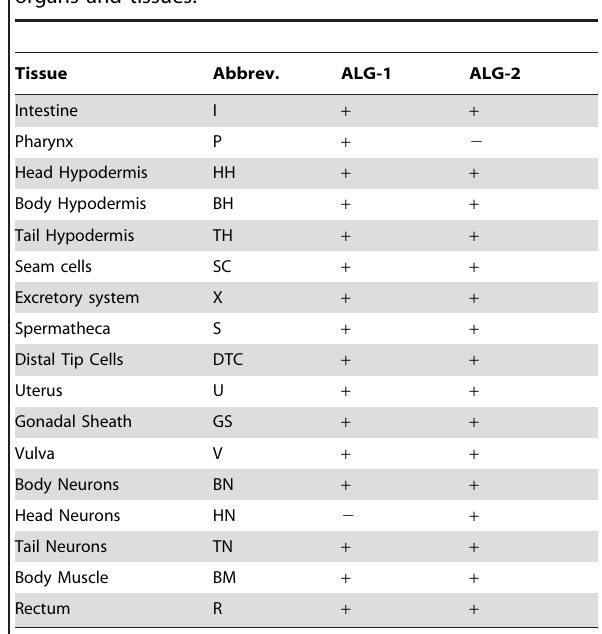
Table 1. Summary of ALG-1 and ALG-2 expression in different organs and tissues.